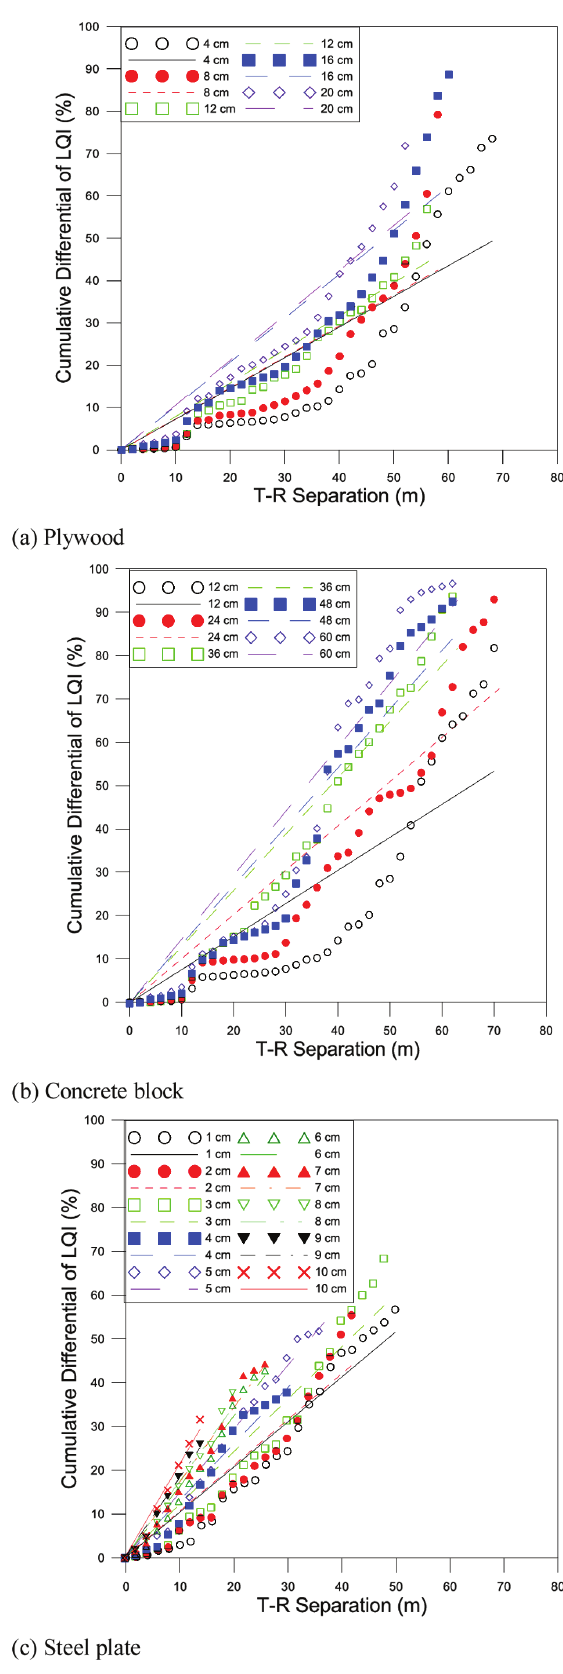
Fig. 10. Cumulative differential dataset and regression curve of PDR in an obstructed